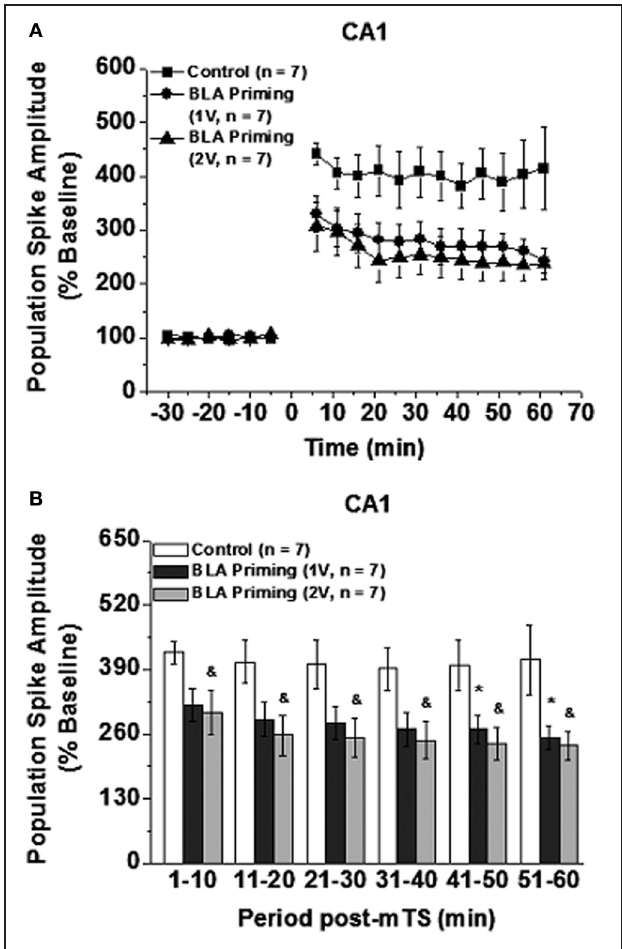
FIGURE 3 | Effect of BLA activation [30s before moderate theta burst stimulation (mTS: 10 trains, each consisting of 10 pulses at 100Hz, with an intertrain interval of 200ms)] on CA1 LTP induced by mTS: mean ( ± SEM percentage of baseline). The mTS reliably induced PS-LTP (A) with respect to the baseline in all the groups (Paired t -Test at 60min after mTS, t s < − 3 . 80, P s < 0 . 01). Both levels of BLA priming activation impaired LTP of PS Amplitude ( summarized in B) . ∗ P / & P < 0 . 05 compared with the control (Two-Way ANOVA with LSD as post-hoc ).